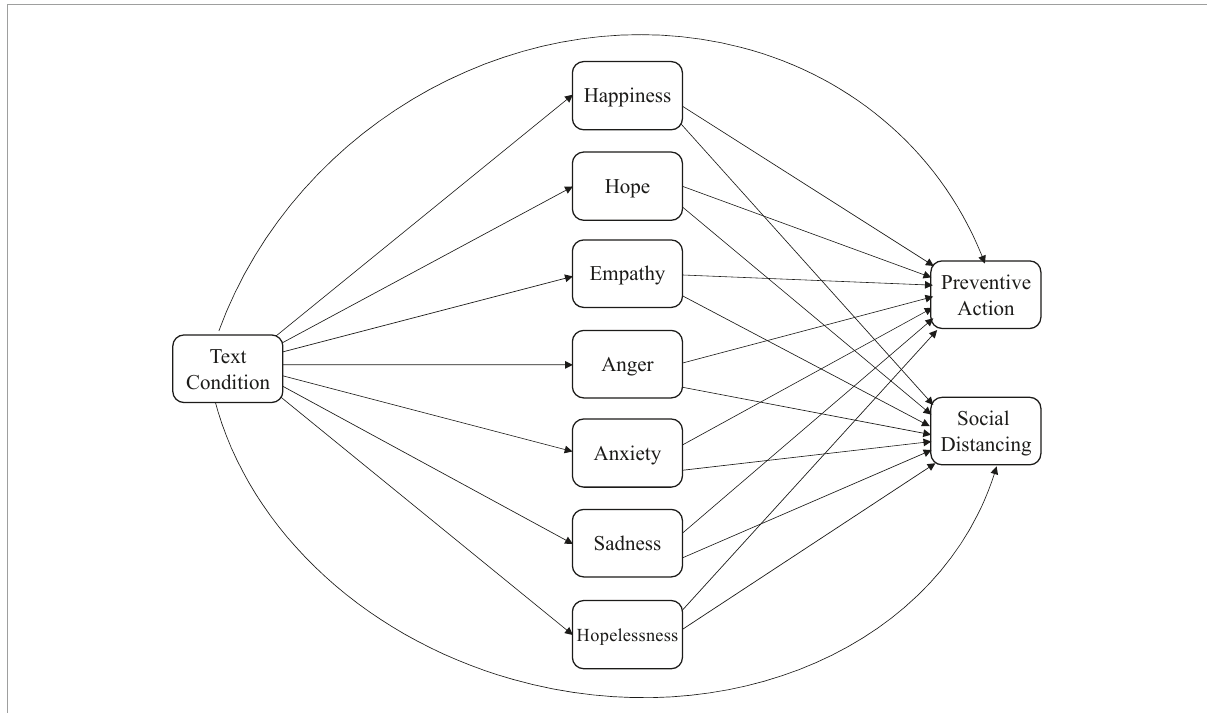
FIGURE1 Hypothesized model of relations between text condition, emotions, and willingness to engage in preventive action.